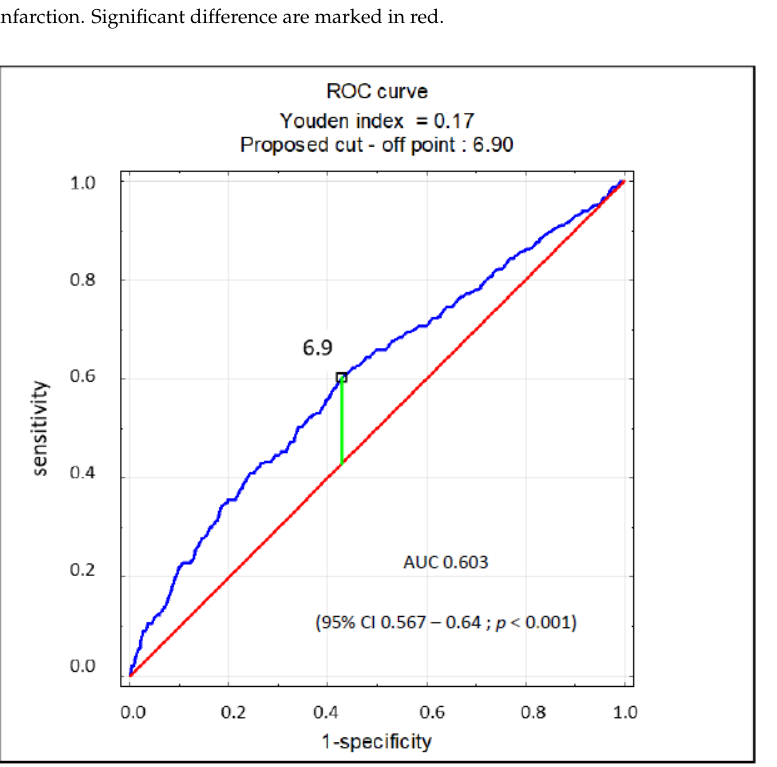
Figure 2. ROC curve for prognostic value of SUA concentration for EF <